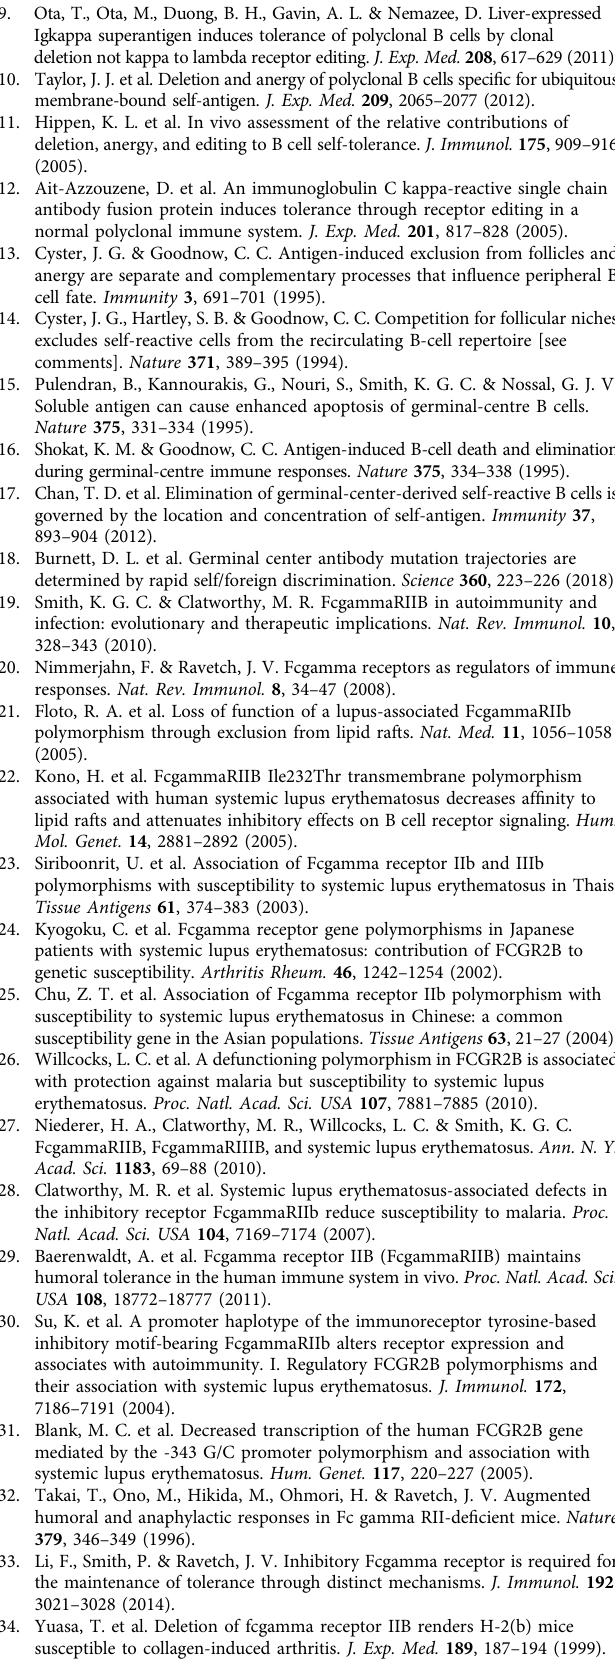
Table 4 (https://www.ebi.ac.uk/ega/). All other relevant data are available from the authors upon reasonable